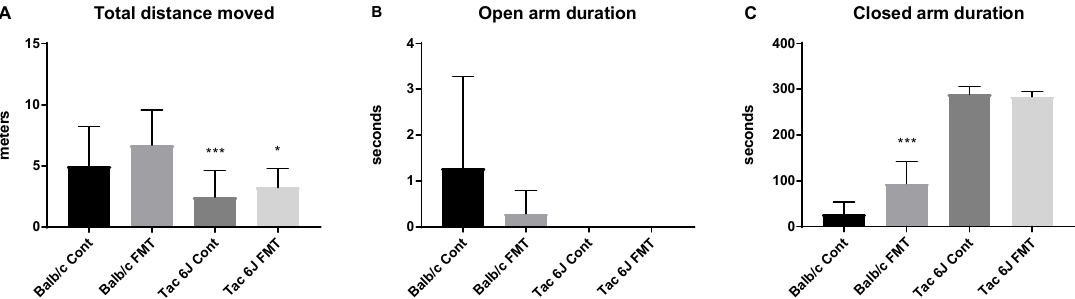
Figure 9. Anxiety of Balb/c and Tac 6J groups after fecal microbiota transplantation (FMT). Using the elevated plus maze test, the anxiety levels of the Balb/c and Tac 6J groups were measured. The Balb/c Anti group received fecal samples of the Tac Cont group and was labelled Balb/c FMT. The Tac 6J